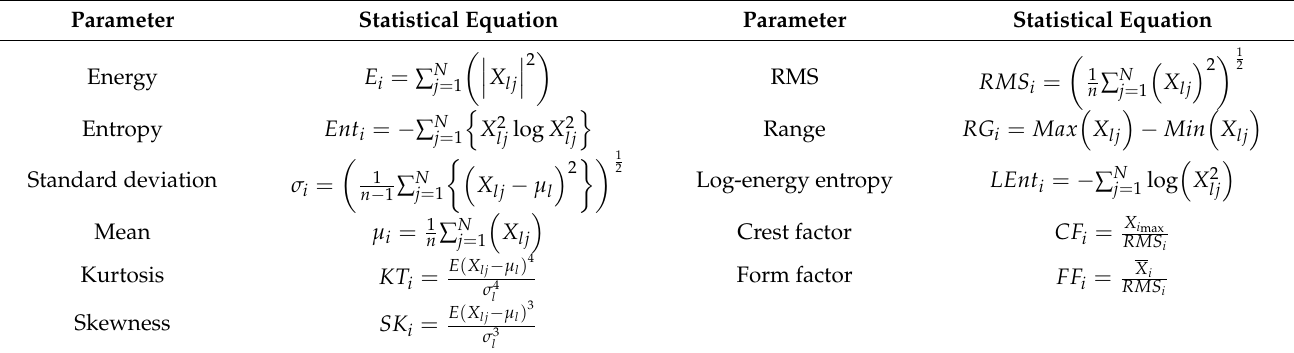
Table 2. Equations for statistical